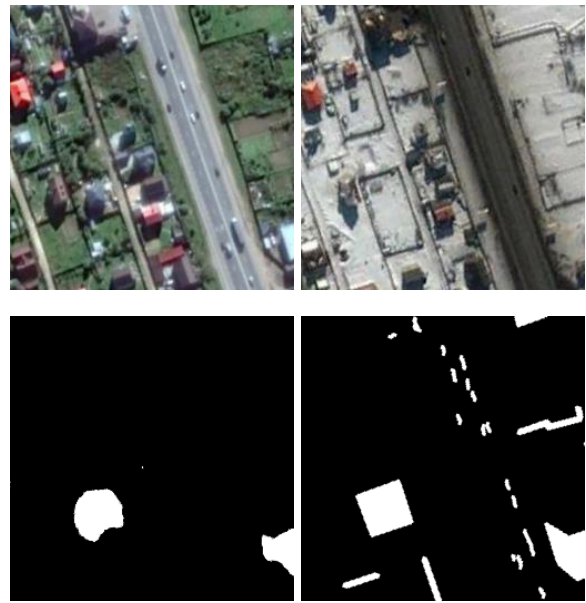
Figure 7. An example of poor detection of small sized objects: top left – input image A, top right – input image B, botton left – synthesized difference map, botton right – ground thruth map